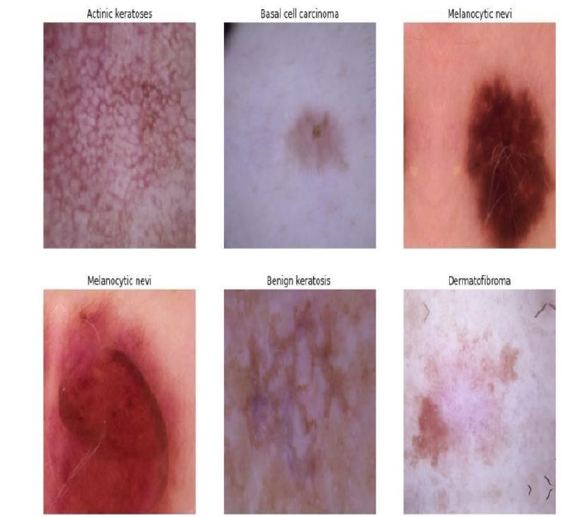
Figure 4.2 : Skin cancer dermoscopic images